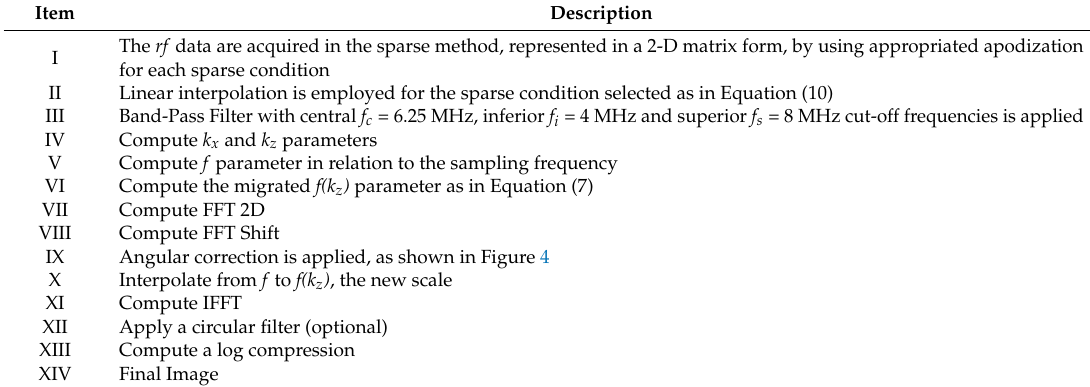
Table 1. Processing steps of the proposed method for generation of US images using plane wave and sparse arrays techniques.